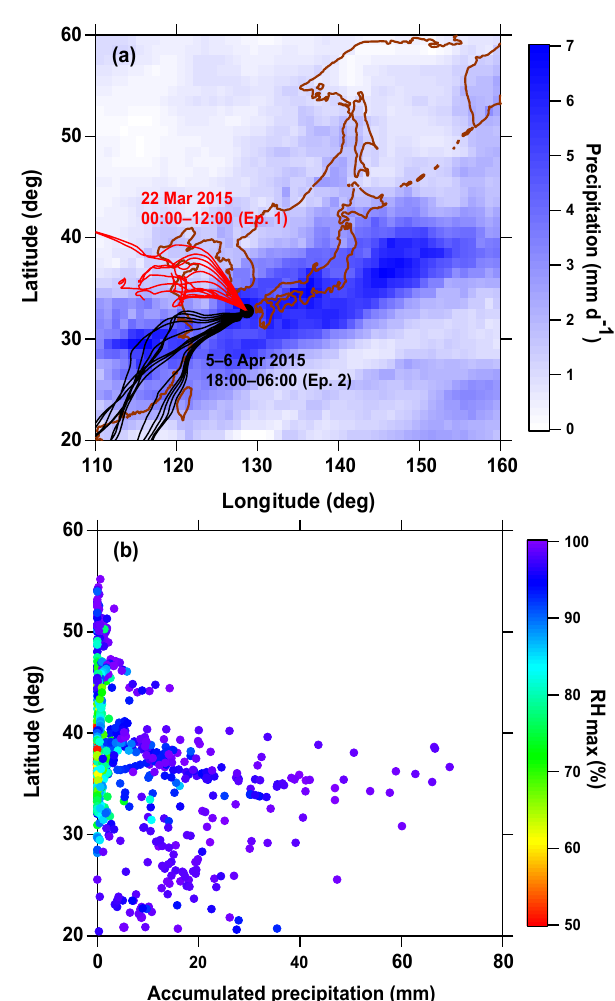
Figure 4. (a) Mean precipitation derived from GPCP during the observation period (11 March–14 April 2015). Three-day back- ward trajectories for selected periods are overlaid (red lines; 00:00– 12:00LT, 22 March 2015, Ep. 1; black lines; 08:00LT 5 April– 06:00LT, 6 April 2015, Ep. 2). (b) The relationship between APT and Lat ORIG (see text for details) colored by the maximum RH along the backward